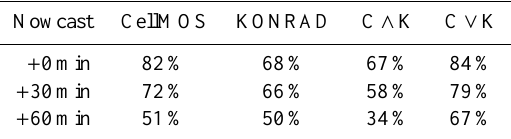
Table 2. Percentage of lightning strokes that occurred (summer 2010) within 20km of cells detected and nowcasted by CellMOS, KONRAD, CellMOS and KONRAD (C ∧ K), CellMOS or KON- RAD (C ∨